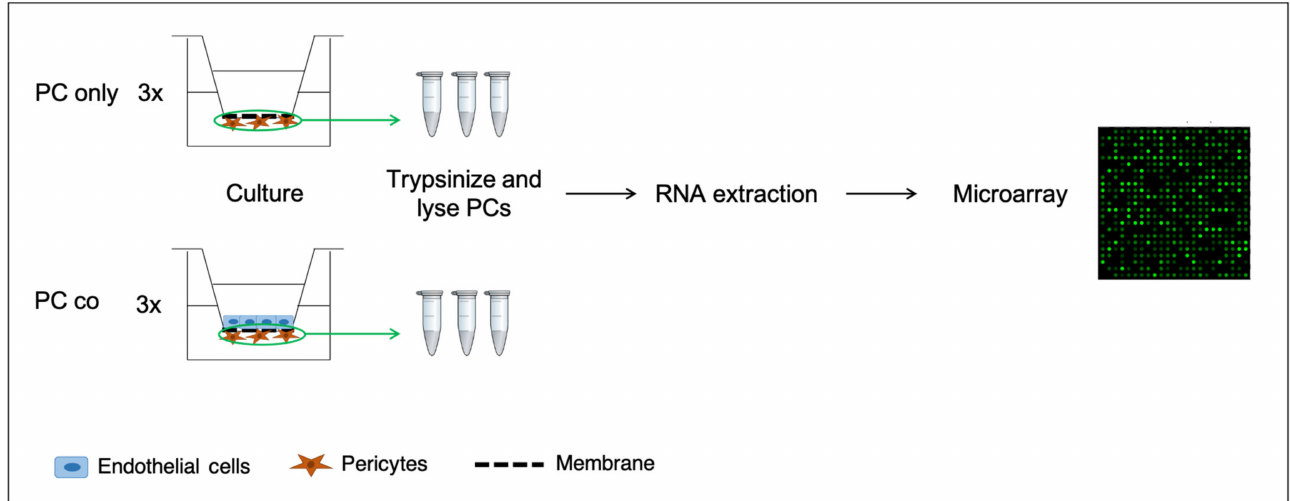
Figure 1. Schematic illustration of the experimental setup. Pericytes (PCs) are grown on the basolateral side of 24-well plate inserts alone (PC only) or in co-culture with ECs on the apical side with direct contact. After 7 days in culture, cells were trypsinized and lysed for total RNA extraction, before microarray analysis was